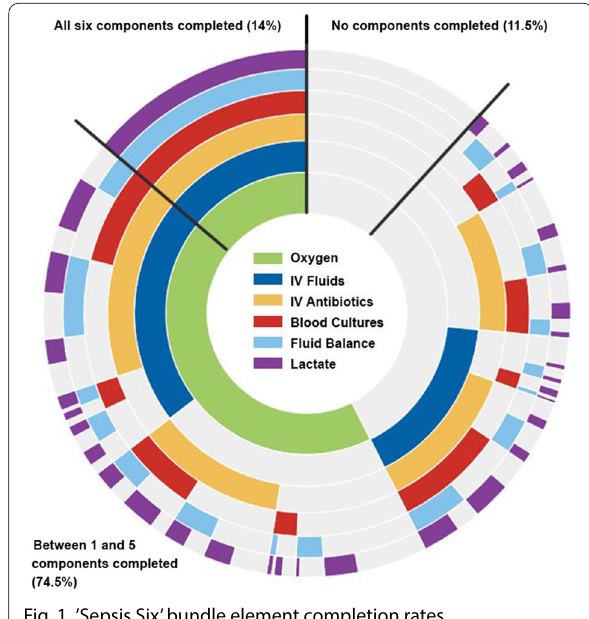
Fig. 1. ’Sepsis Six’ bundle element completion